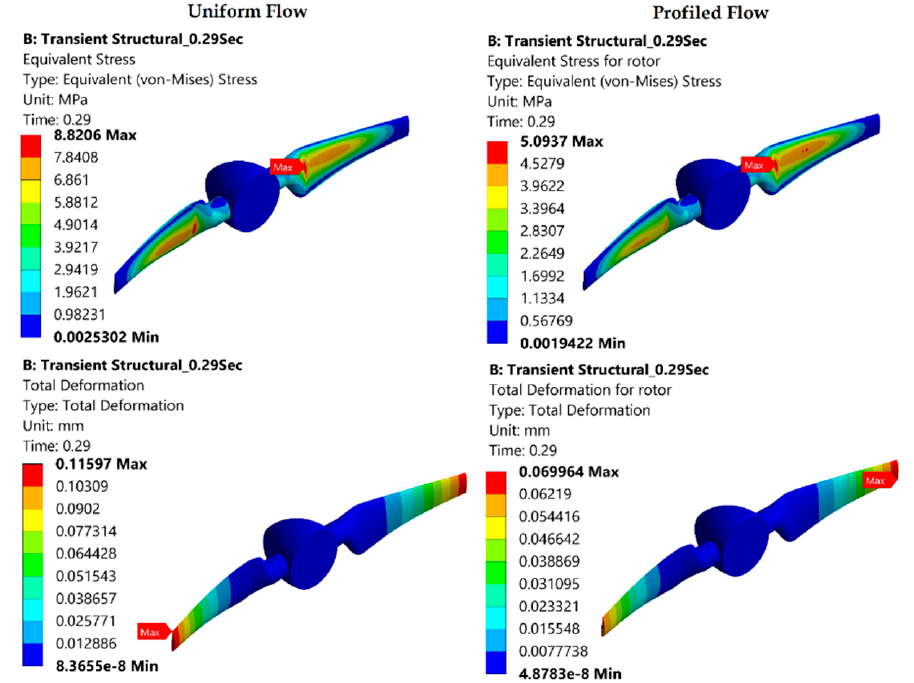
Figure 7. Contours of Equivalent (Von-Mises) stress and Total deformation for rotor for uniform and profiled flow.